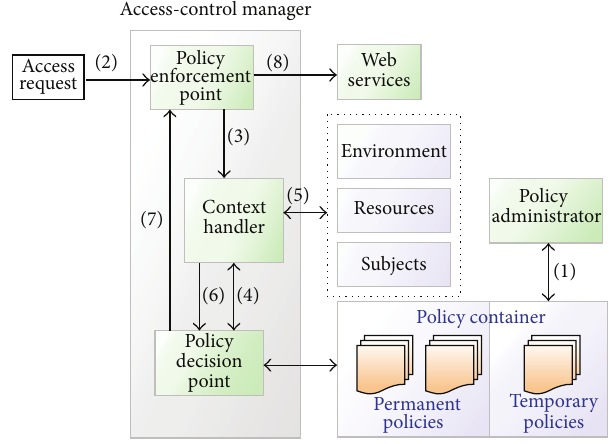
Figure 3: Access-control